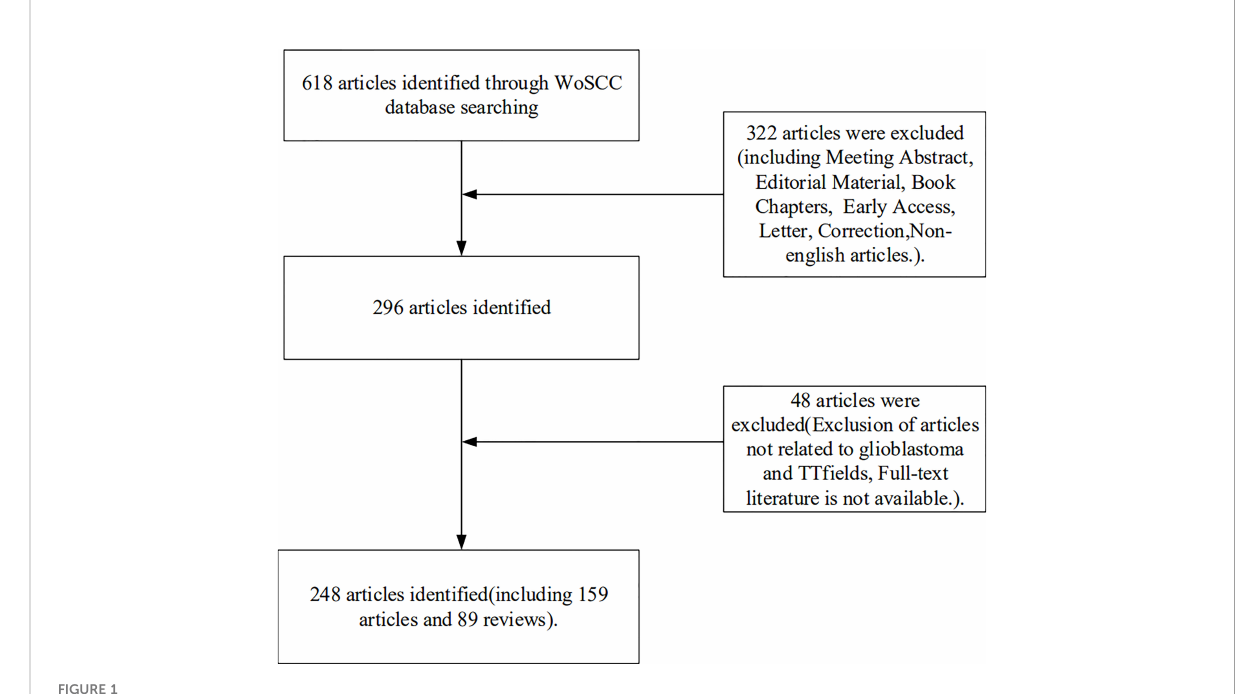
FIGURE 1 Flow chart of the literature selection